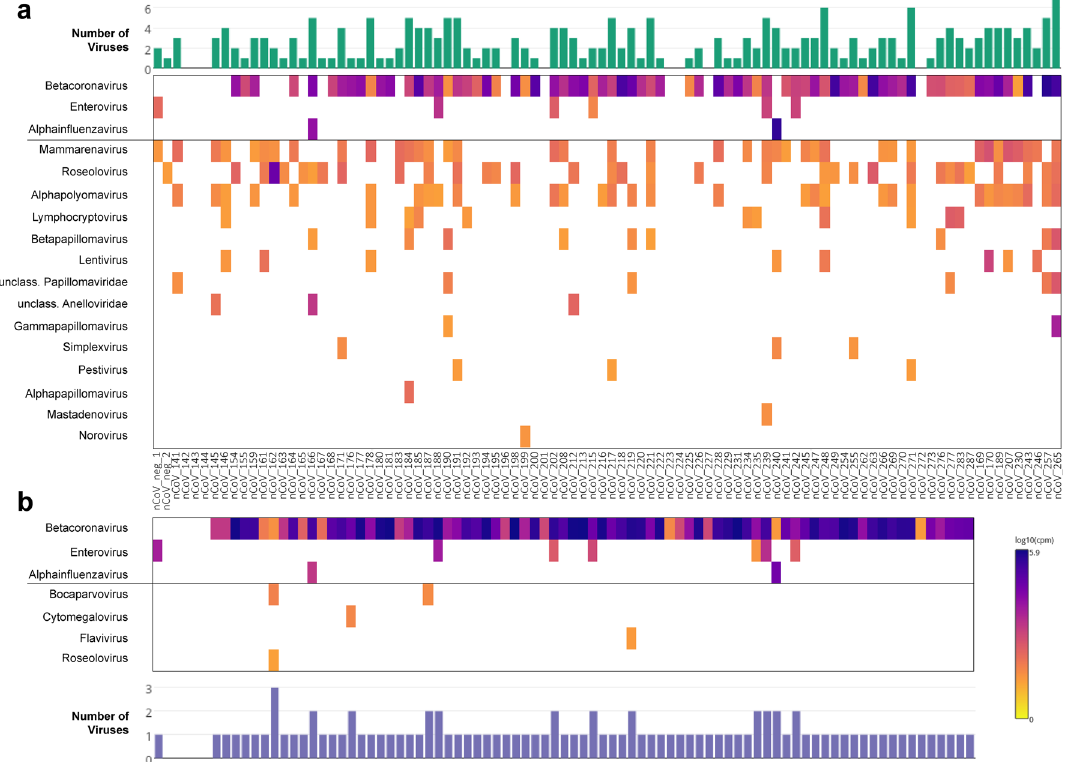
Figure 1. Viruses detected in SARS-CoV-2 case specimens by two hybrid-capture sequencing approaches. ( a ) VirCapSeq (n = 92); and ( b ) Twist Respiratory Virus Panel (n = 83). Heatmap of viral reads in log scale and represented at the genus level. Sample IDs apply for both panels ( a ) and ( b ), indicating overlapping samples sequenced by both approaches. Horizontal line separates respiratory viruses (above) from non-respiratory viruses (below). Bar charts indicate number of viruses detected per specimen. nCoV_neg_1 & 2 are clinical control specimens from two individuals confirmed negative for SARS-CoV-2 by